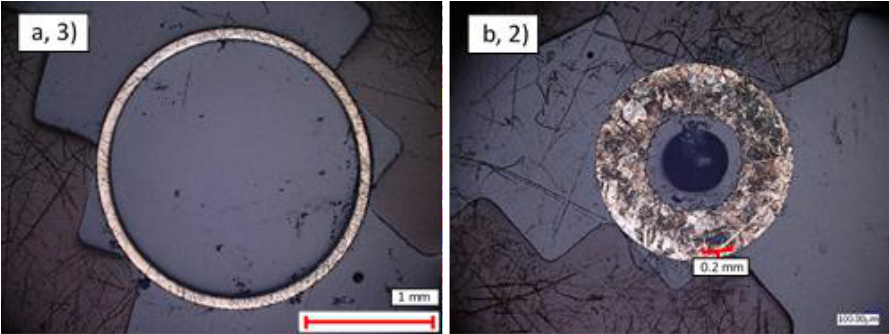
Figure 10. ×1000 magnification of the etched cross-sectional surface of samples: ( a ) Ti thin-walled pipe (3); ( b ) SS thick-walled pipe (2).